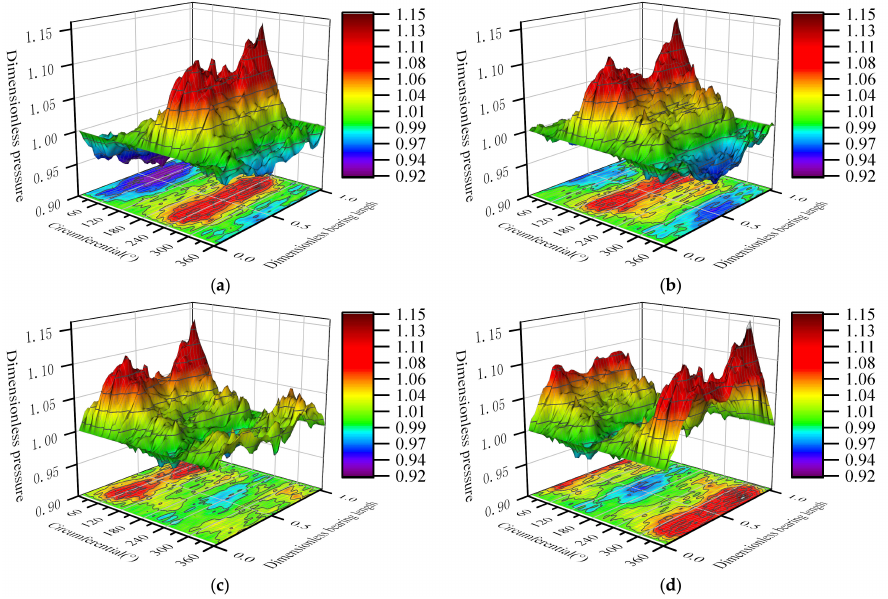
Figure 6. Dimensionless pressure distribution of shaft 1 at 6000 r/min at different angles: ( a ) 90 ◦ ; ( b ) 180 ◦ ; ( c ) 270 ◦ ; ( d ) 360 ◦ .